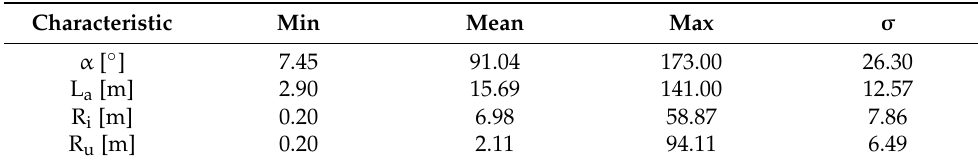
Table 6. Characteristic values of the geometrical